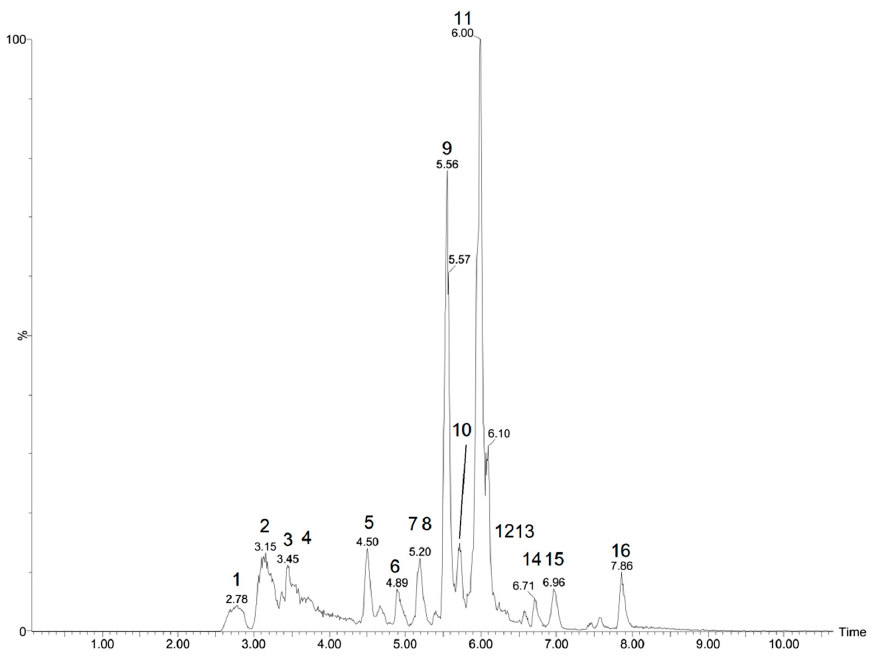
Figure 1. Croton heliotropiifolius root extract chromatogram in the negative mode. Through the analysis of the 16 peaks shown in the chromatogram in negative mode (Table 2, Figure 2), it was possible to identify nine compounds based on the literature available for the Euphorbiaceae family, including four acids (quinic, m/z 191.0549; malic, m/z 133.0141; citric, m/z 191.0185; and hydroxybenzoic acid derivative, m/z 253.0347), four flavonoids (quercetin-O-glycoside, kaempferol-O-glucoside, quercetin and apigenin), m/z 463.0894), a lignan (pinoresinol , m/z 357.1323) and five diterpene not identified in the specie (Figure 3). Table 2. Compounds identified in the aqueous extract of Croton heliotropiifolius roots in the nega- tive mode. Peak RT min a